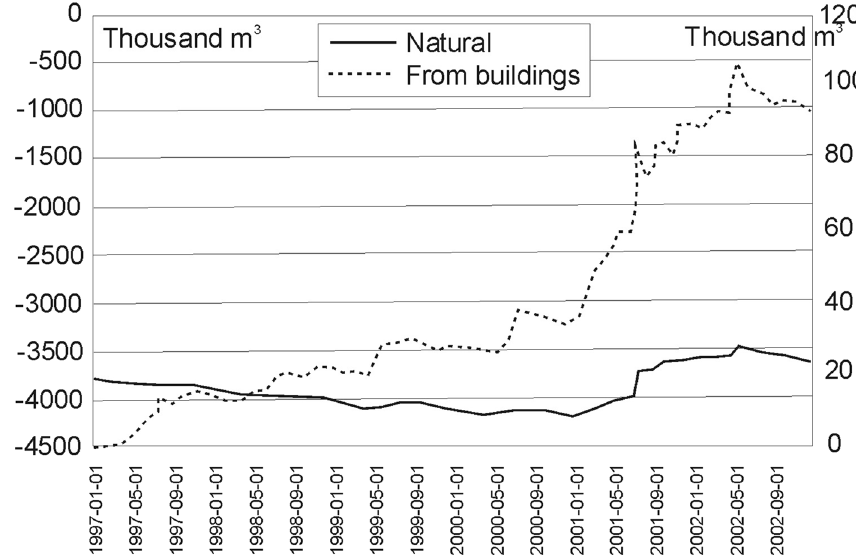
Fig. 13 Retention in aeration zone in natural conditions and with building